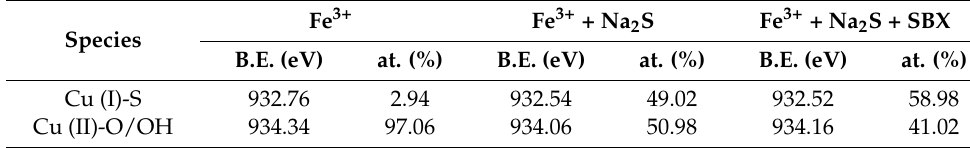
Table 4. Cu 2p quantification of digenite with different treatments in the presence of Fe 3+